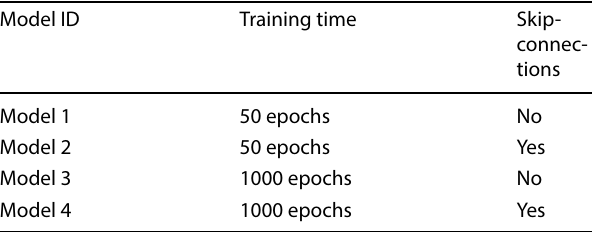
Table 3 Autoencoder model training parameters for CARLA dataset Model ID